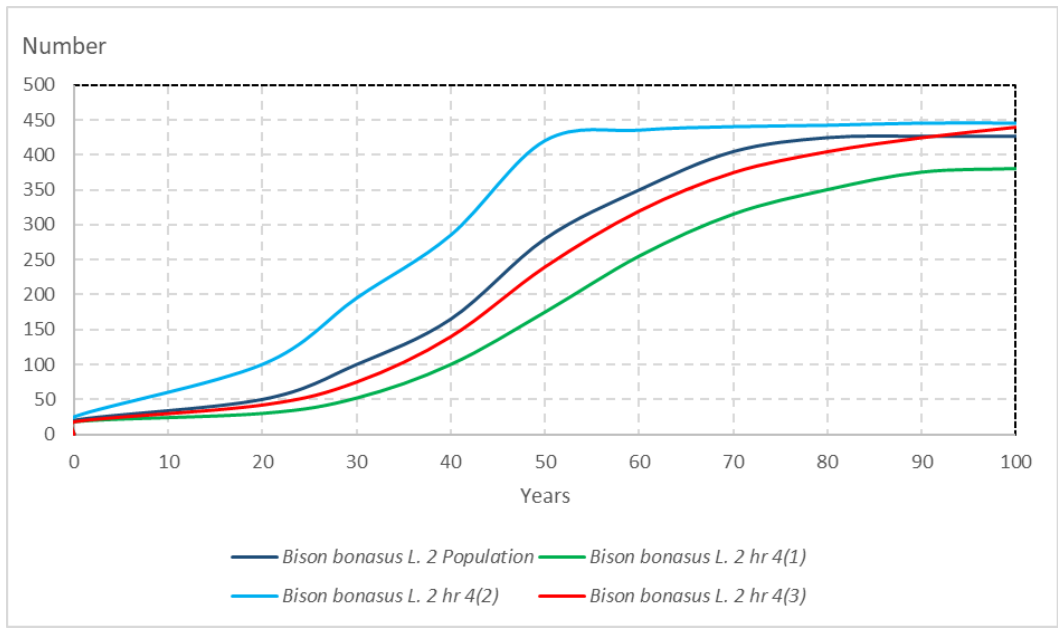
Figure 6. The number of specimens at the end of the time period for the scenario with supplemen- tation (European bison 2) and hr4 (1), hr4 (2), hr4 (3) simulations.